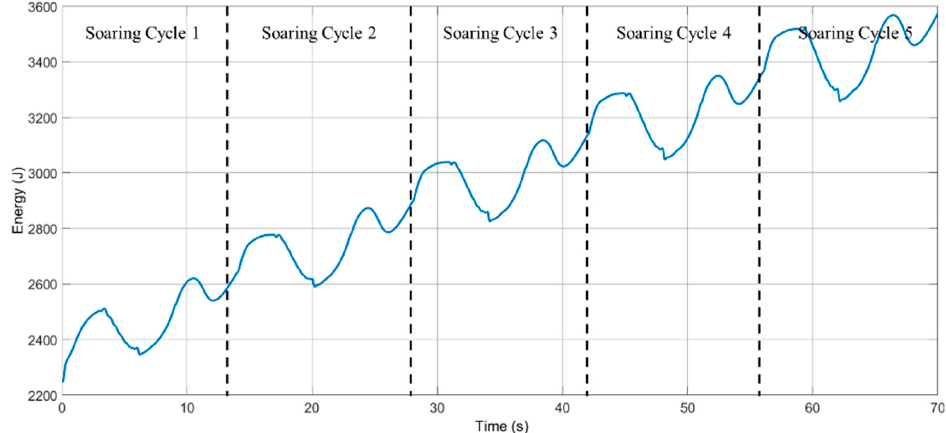
Figure 11. The energy change during the dynamic soaring.